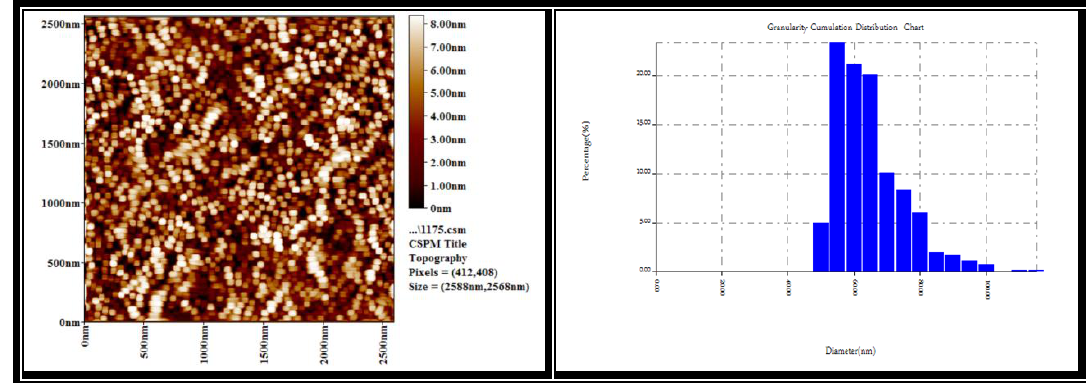
Fig.4: Surface roughness and histogram of pure TiO